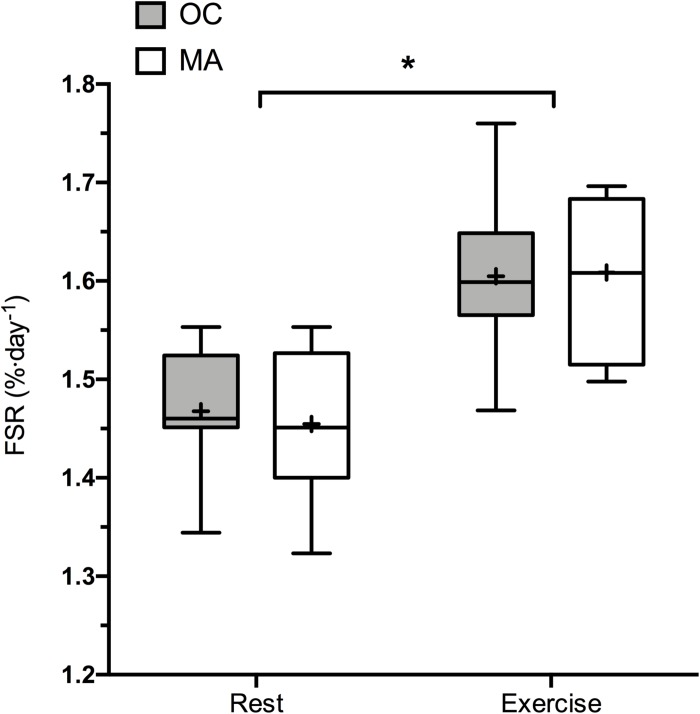
48 h Integrated myofibrillar Protein Synthesis rates in the rested state and following a bout of resistance exercise in older untrained controls (OC, gray bars) and Master Athletes (MA, white bars). The symbol “∗” indicates significantly different from rest values (P < 0.05). Values are presented as the median (central horizontal line), 25th and 75th percentiles (box), minimum and maximum values (vertical lines) and mean (cross).